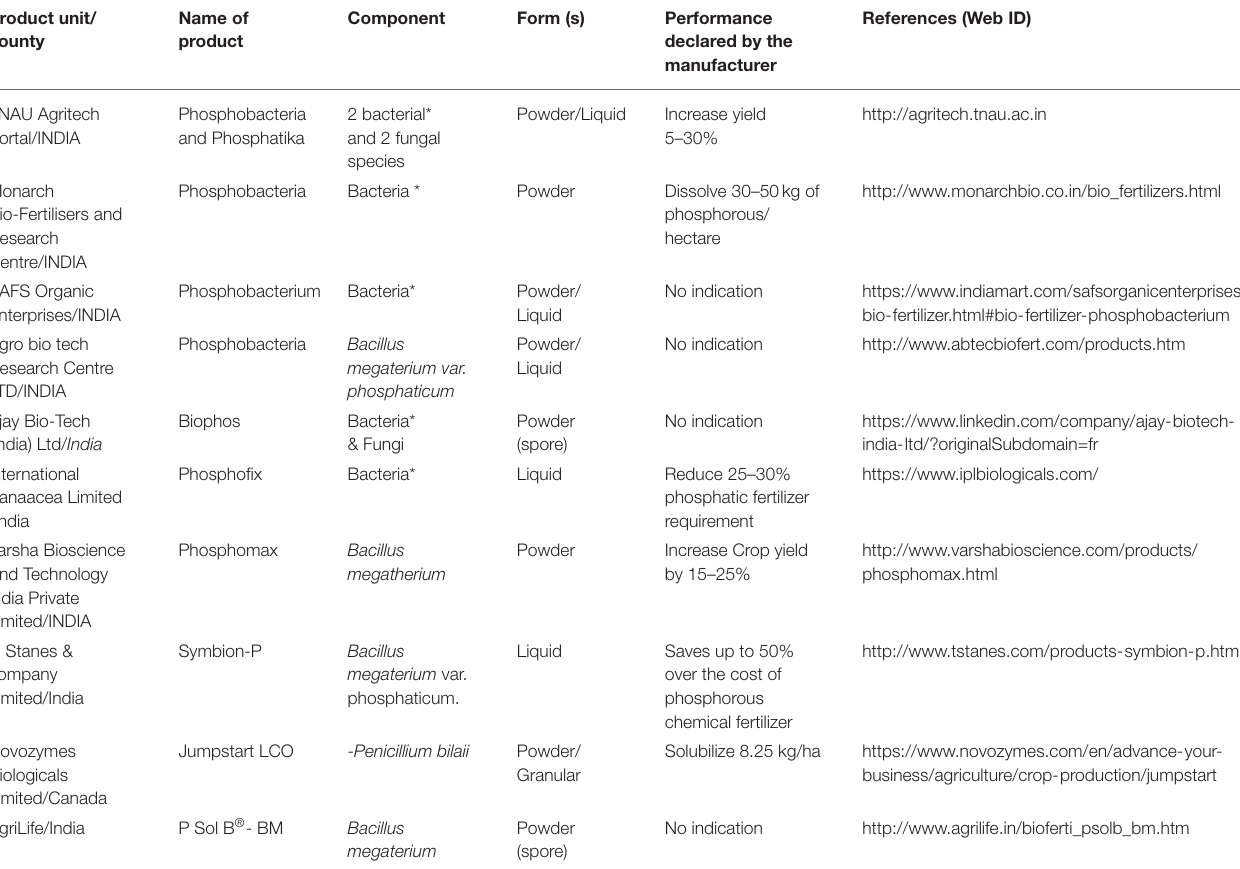
TABLE 1 | Main manufacturer of biofertilizer based on P-solubilizing microbes. Product unit/